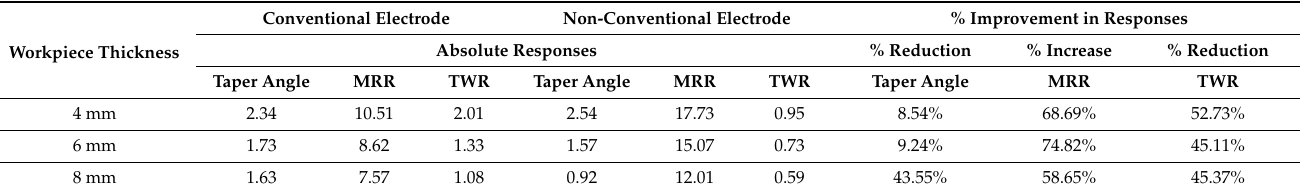
Table 8. Confirmatory experiments and comparison between conventional and non-conventional electrode